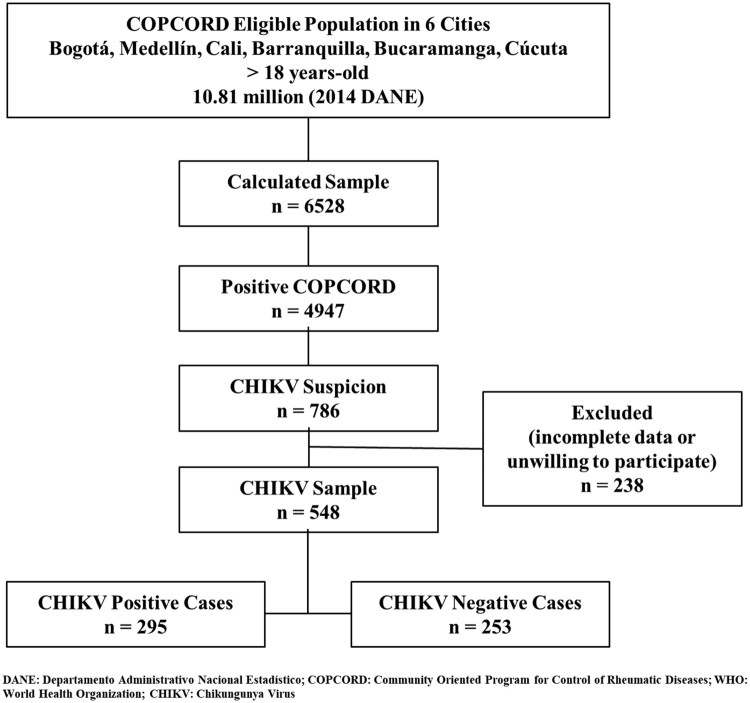
Profile of the study population. WHO: World Health Organization; CHIKV:
chikungunya virus.